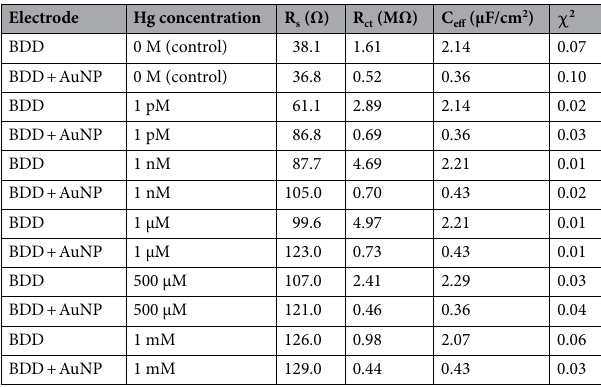
Table 1. The parameters extracted from the equivalent circuit (Fig. 5a) fit of the raw EIS data for the BDD and BDD + AuNP electrodes at open circuit potential. The parameters extracted from the equivalent circuit fit of the EIS data for these electrodes at the other potentials tested are presented in the Supplementary Information.